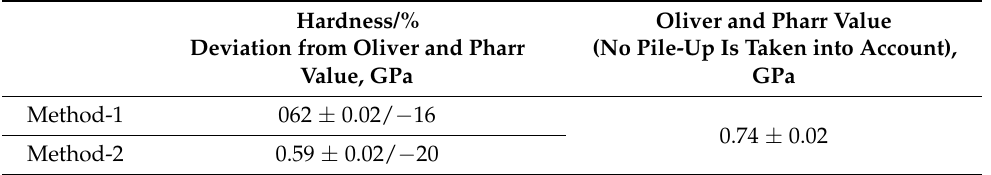
Figure 8. SPI of the pile-up phenomenon in annealed DHP Cu. Table 3. Deviation to the Oliver and Pharr analysis pile-up. This was evaluated by applying method-1 and method ‐ 2.